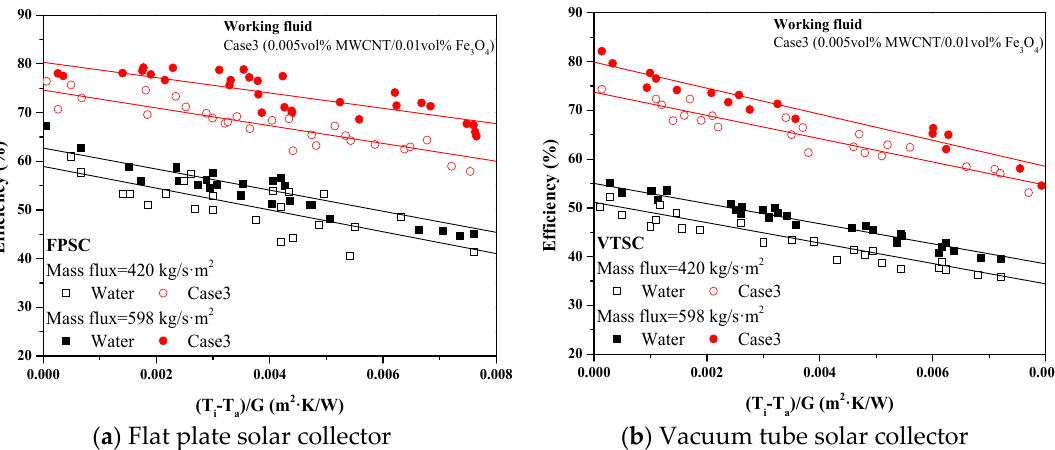
Figure 8. Variation of efficiency in the flat plate and vacuum tube solar collector depending on the mass flux of working fluid.